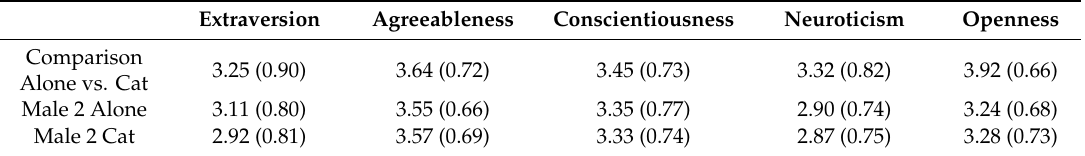
Table 5. Survey / Male 2 Big Five